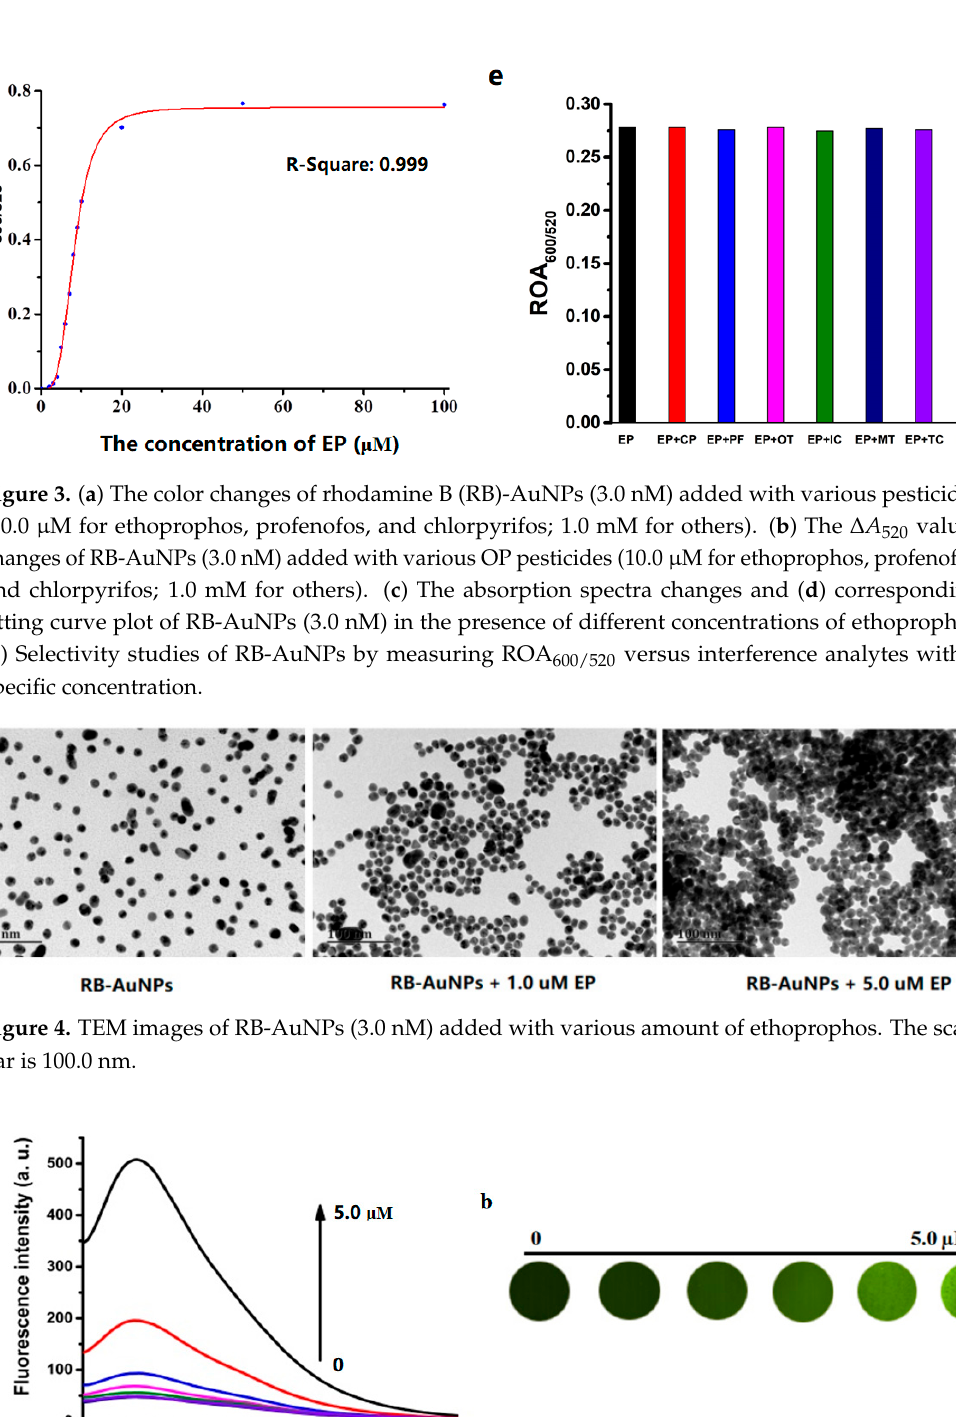
Figure 5. ( a ) The variation of fluorescence intensity and ( b ) fluorescence imaging of RB-AuNPs (3.0 nM) added with various amounts of ethoprophos (EP) (0–5.0 µ